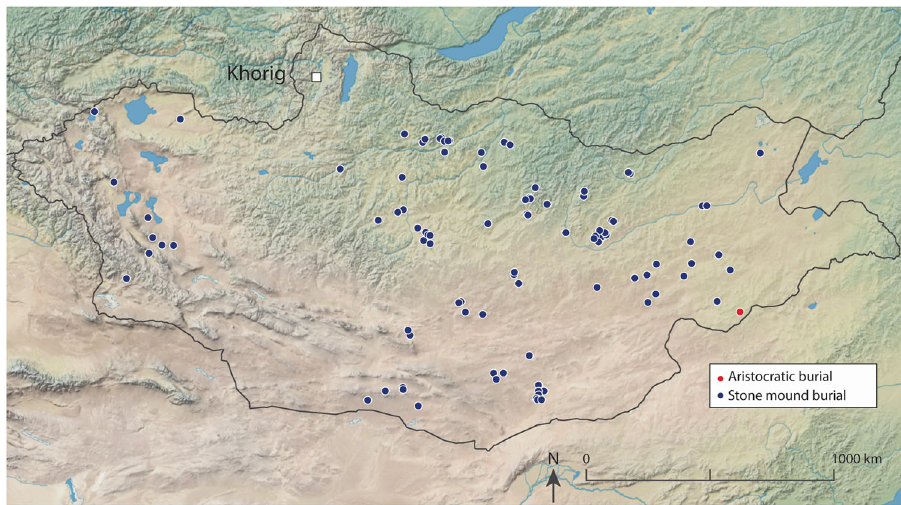
Fig. 3 Location of the elite cemeteries of Khorig I and Khorig II (identi fi ed here as Khorig) in relation to other Mongol-era burials (elite and non-elite) in Mongolia. This map was produced using Adobe Illustrator CC 2020 and using the Natural Early Data maps from https://www.naturalearthdta.com/ downloads/ by AVM and Michelle O ’ Reilly (Graphic Designer for the MPI-SHH) and John Klausmeyer (Illustrator for the UMMAA).